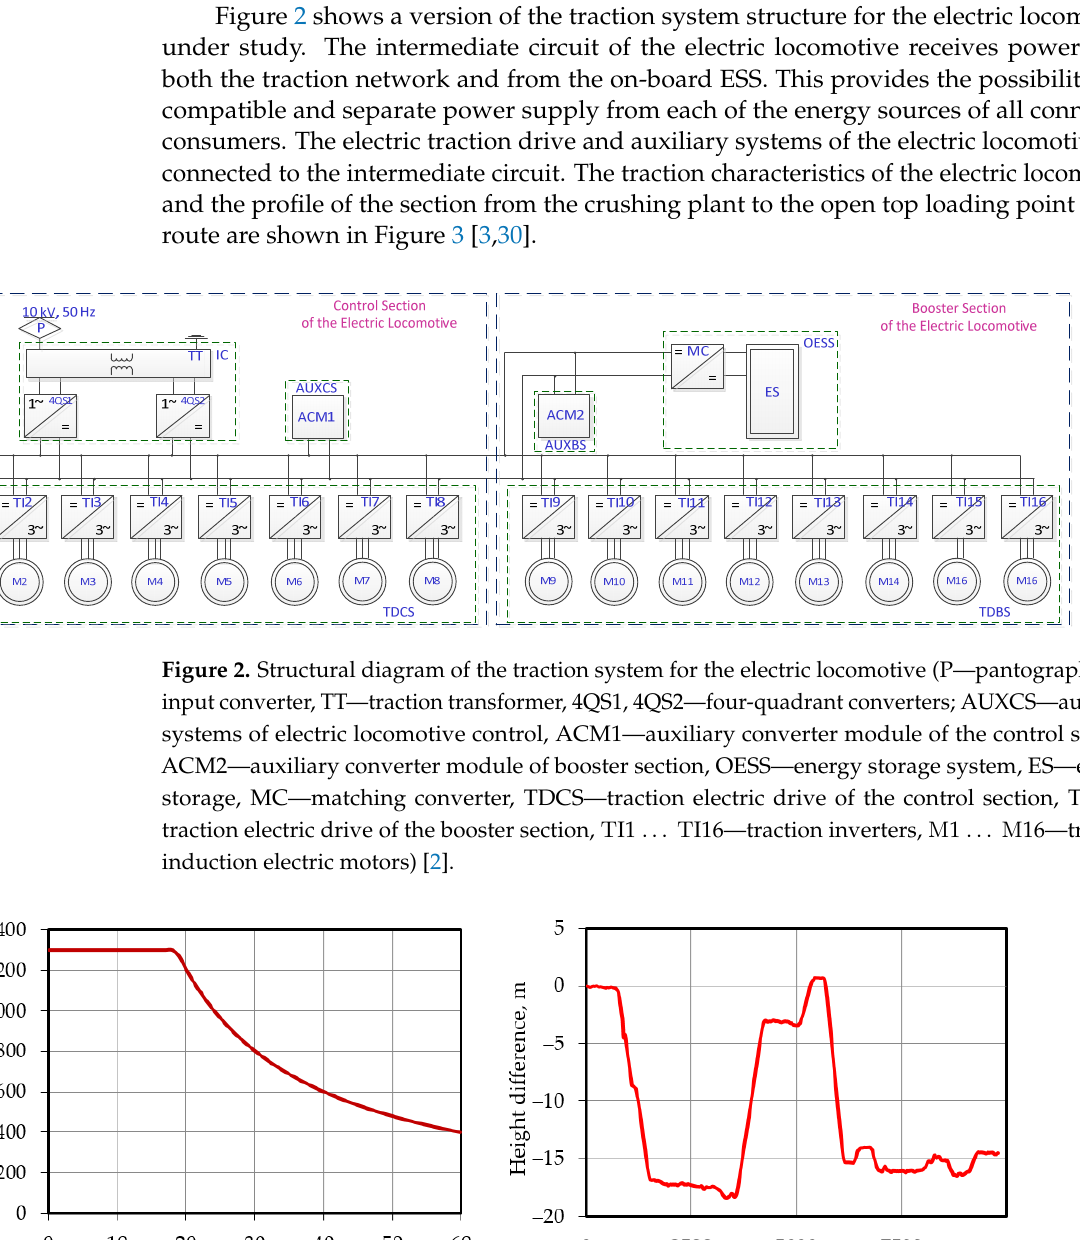
Figure 4. Dependence of the tangential power on the electric locomotive (I—empty half-passage, II—shunting during loading, III—cargo half-passage, IV—shunting during unloading).